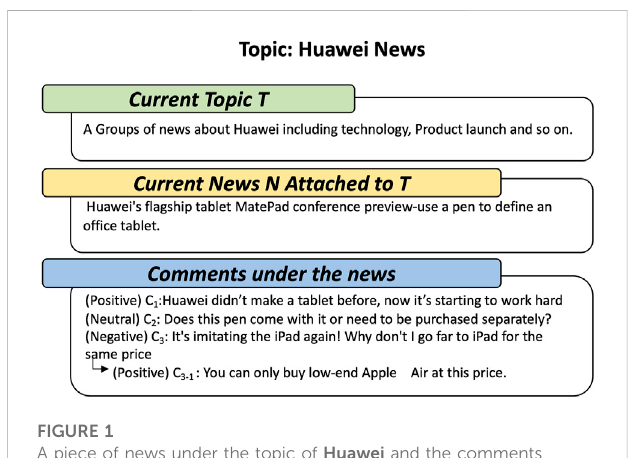
FIGURE 1 A piece of news under the topic of Huawei and the comments under the news. Each comment is labeled with positive, negative, or neutral depending on its attitude to the